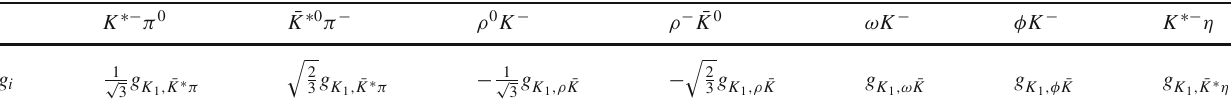
Table 6 Couplings of the I = 1 / 2 axial-vector resonances K 1 ( A ) and K 1 ( B ) to the different V P channels. The values of the couplings are different for both